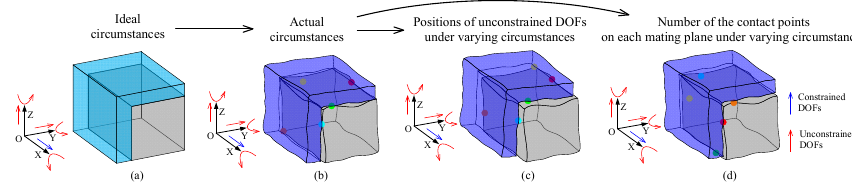
Figure 2. Position and orientation deviations generated after multiple planes of two parts are assembled. DOF, degree of freedom. ( a ) Ideal circumstances, ( b ) Actual circumstances, ( c ) Positions of unconstrained DOFs under varying circumstances, ( d ) Number of the contact points on each mating plane under varying circumstances.